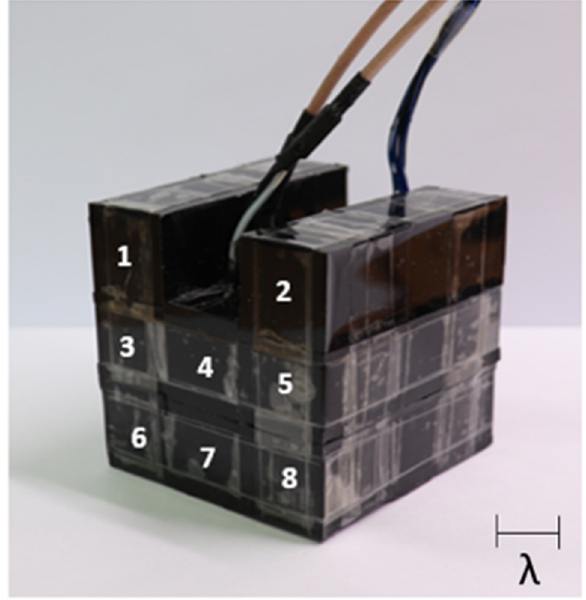
Figure 6. Fabricated transducer.